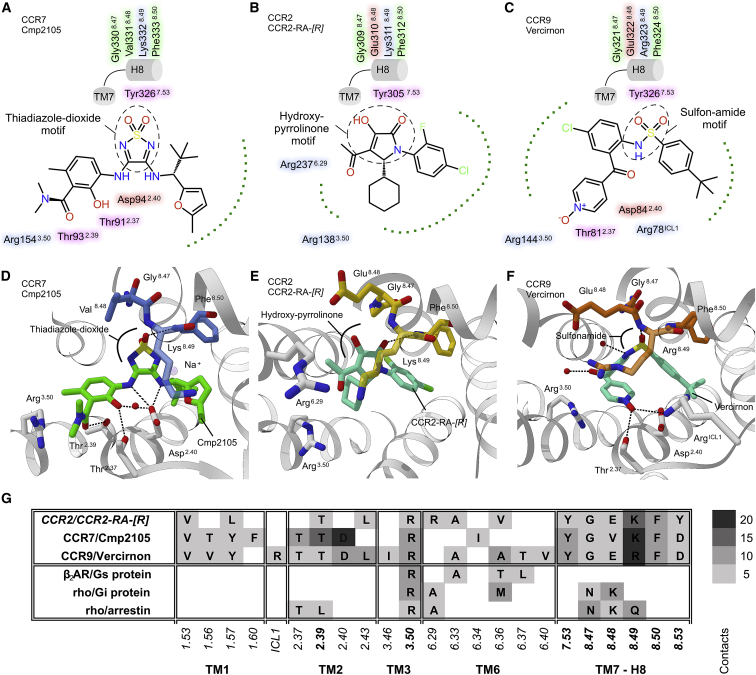
Binding Mode Comparison for Cmp2105 (CCR7), CCR2-RA-[R] (CCR2), and Vercirnon (CCR9)(A–C) Schematic ligand interaction profiles with protein residues colored according to their chemical nature (hydrophobic in green, polar in pink, acidic in red, and basic in blue). Dotted green lines represent regions with hydrophobic interactions.(D–F) Structural comparison of the CCR7 allosteric binding pocket with those of CCR2 and CCR9 reveals strong similarities in allosteric chemokine receptor ligand binding to a conserved patch of residues in the TM7-H8 turn (CCR7 in blue, CCR2 in yellow, and CCR9 in orange).(G) Summary of interatomic contacts (defined as pair of atoms with < 4 Å distance) in the allosteric binding pocket with CCR2-RA-[R] (PDB: 5T1A), Vercirnon (PDB: 5LWE), and a selection of GPCR-effector complexes (PDB: 3SN6, 6CMO, and 5DGY). Residues are shown in single-letter code with critical sites emphasized with bold letters. The grayscale indicates the number of contacts to the respective ligand or effector protein.